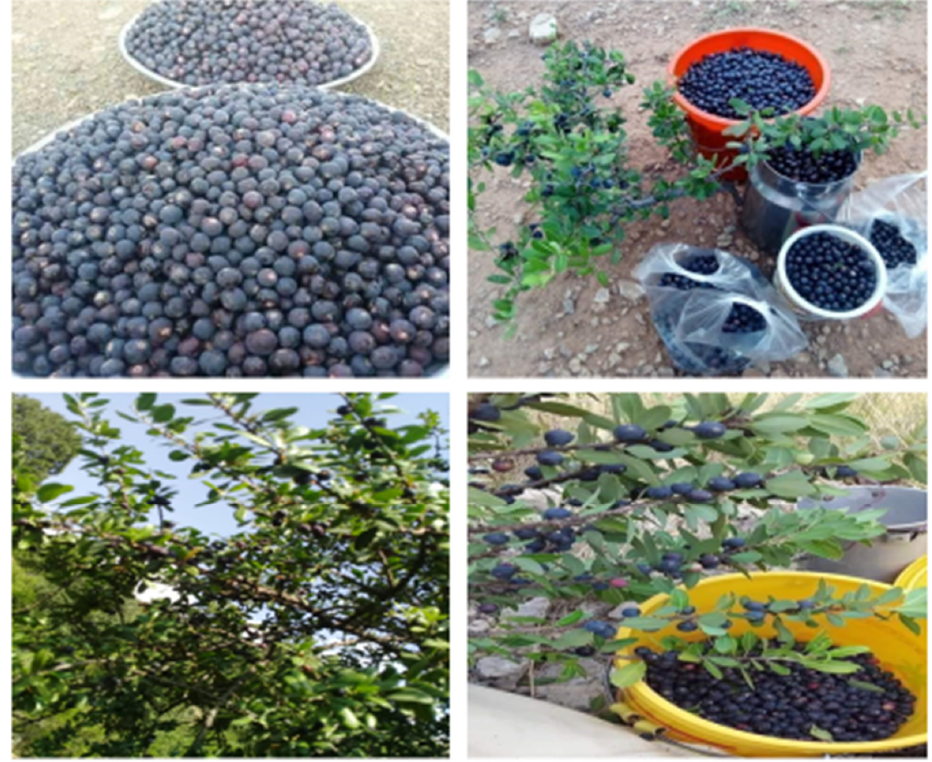
Figure 9. Monotheca fruits in the local market.